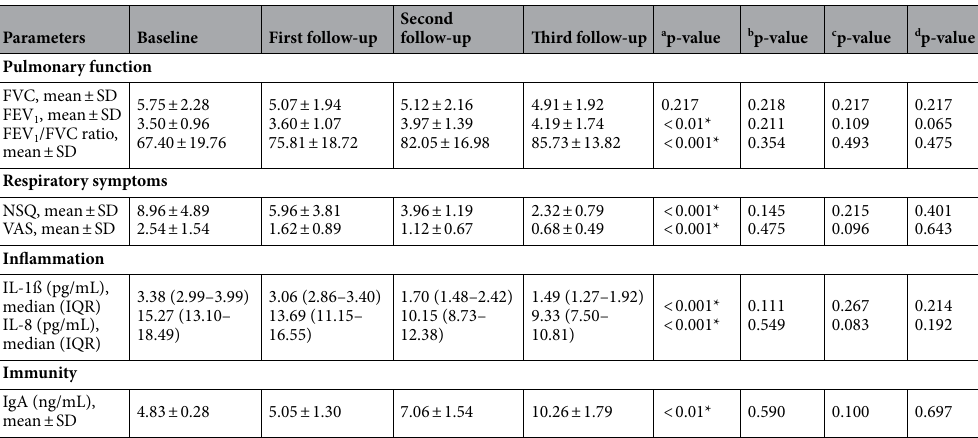
Table 3. Changes in respiratory health and immunity of participant during study as indicated by clinical assessment and laboratory outcomes. IL-1ß and Il-8 were analysed from nasal lavage sample, IgA was analysed from salivary sample. FVC Force Vital Capacity; FEV 1 Forced Expiratory Volume; NSQ Nasal Symptoms Questionnaire; VAS Visual Analogue Scale; IL-1ß Interleukin 1ß; IL-8 Interleukin 8; IgA Immunoglobulin A. Statistically significant p values are marked in asterisks (*). a p-value was calculated using general linear model (GLM) for repeated measures model, with sampling time point as within-subjects factor. b p-value was calculated using general linear model (GLM), with gender tested as between-subject effect. c p-value was calculated using general linear model (GLM), with age tested as between-subject effect. b p-value was calculated using general linear model (GLM), with BMI tested as between-subject